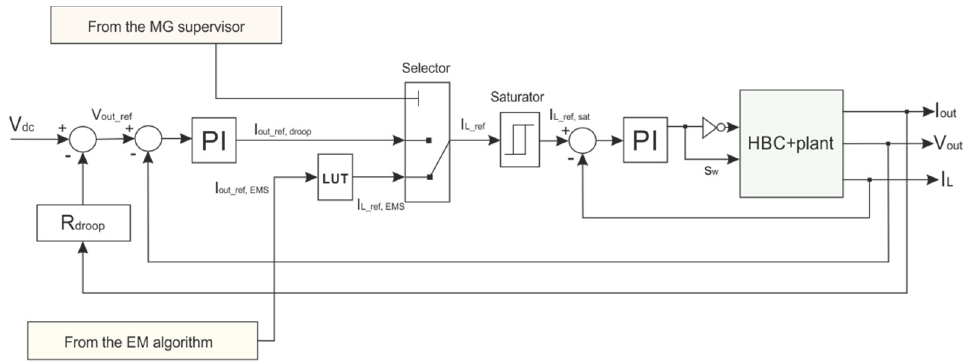
Figure 3. Control scheme of the HBCs interfacing the FC and battery with the MG DC